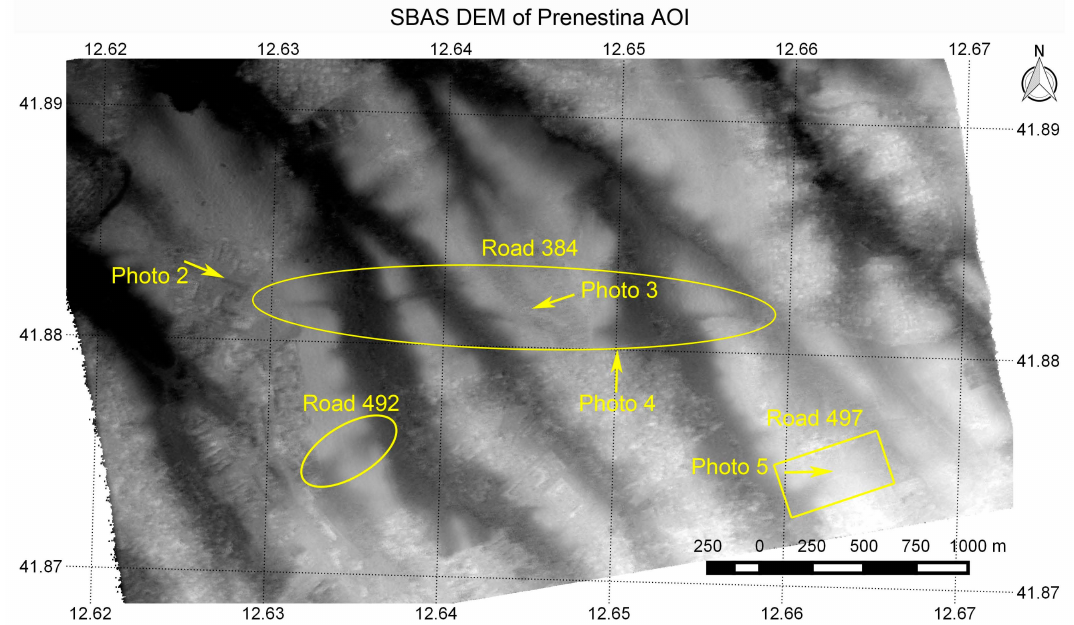
Figure 30. SBAS DEM produced from CSK Spotlight imagery over the Prenestina AOI. Annotations in yellow show the locations of residues and the locations and directions from which photographs were acquired on the ground. COSMO SkyMed data provided by the Italian Space